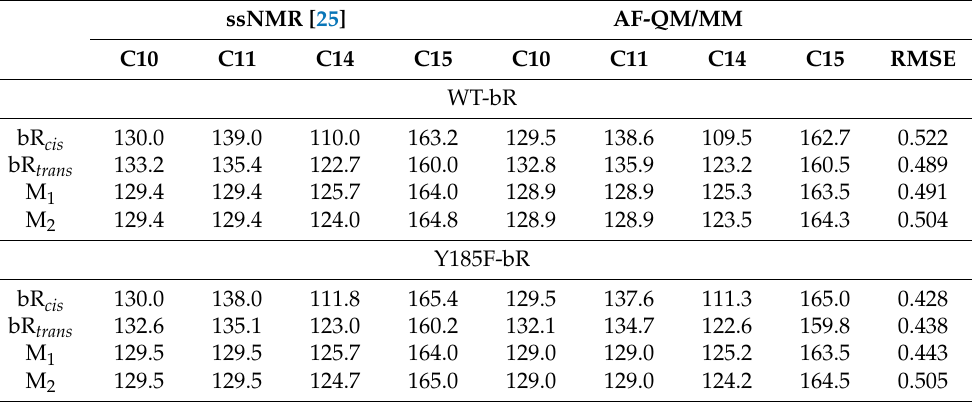
Table 1. Chemical shifts of the [10, 11, 14, 15- 13 C 4 ]-retinal-regenerated WT-bR and Y185F-bR in the dark-adapted and M states as determined by ssNMR and calculated by AF-QM/MM. ssNMR